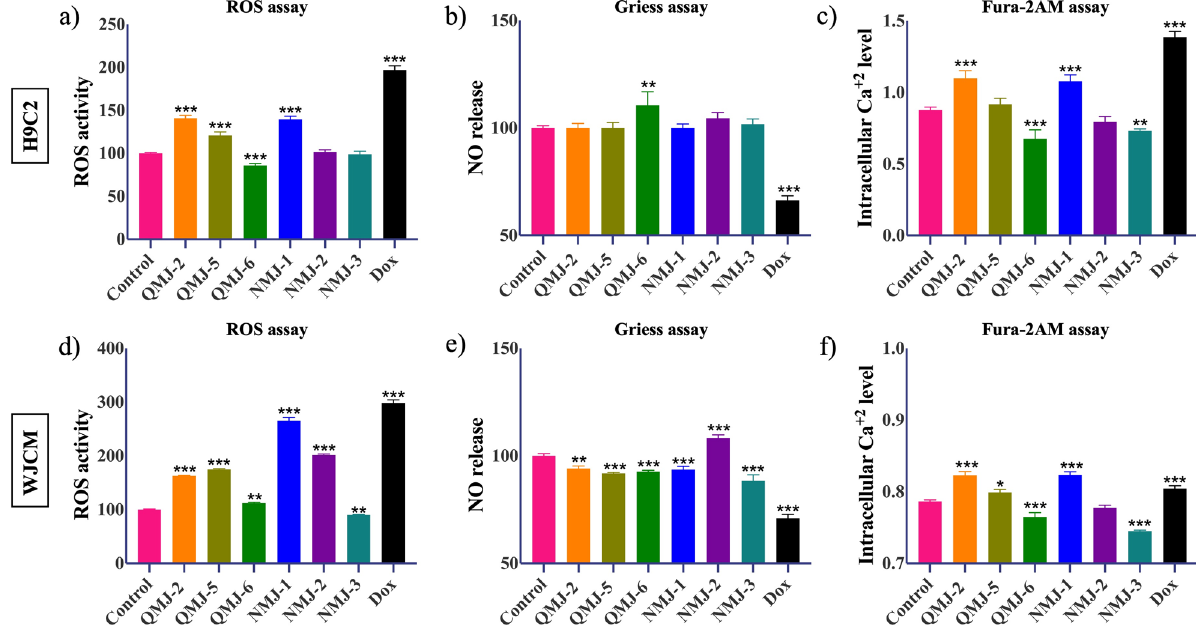
Figure 3. Detection of oxidative stress and intracellular Ca 2+ flux in H9C2 cells and WJCM. ( a , d ) Reactive oxygen species (ROS) activity and, ( b , e ) nitric oxide (NO) release by Griess assay were assessed after treatment with quercetin or cinnamic acid analogues for 24 h. ( c , f ) Accumulation of calcium after the treatments was estimated by using Fura-2AM dye. Data represented as mean ± SEM (n = 3), *p < 0.033, **p < 0.002, ***p < 0.001. Dox